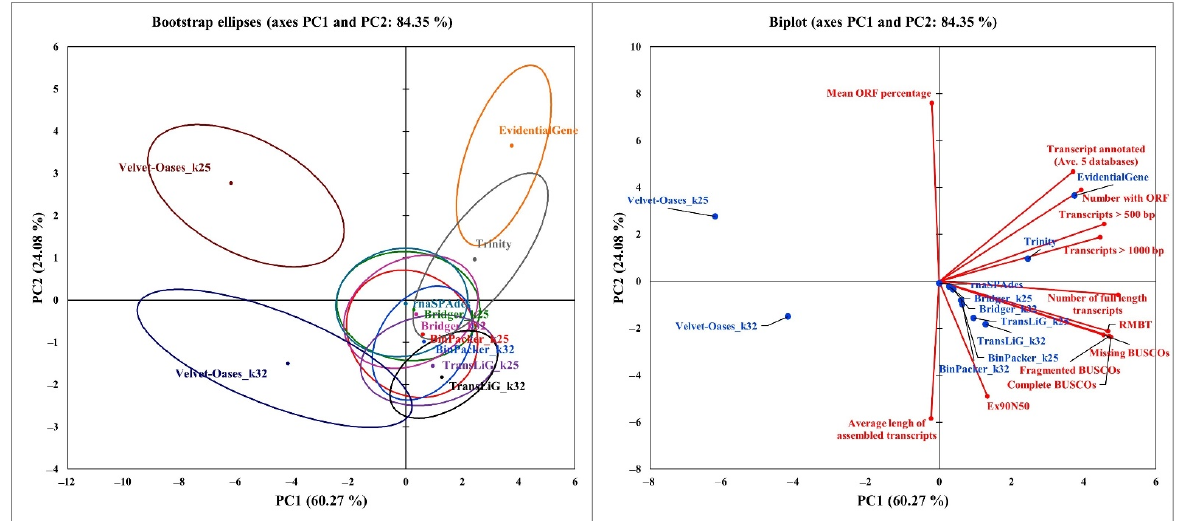
Figure 9 . Principal component analysis of evaluation metrics for different assemblers. ( A ) Confidence ellipses obtained by PCA for the mean points of different transcriptomes. ( B ) Biplot of the first two principal components.